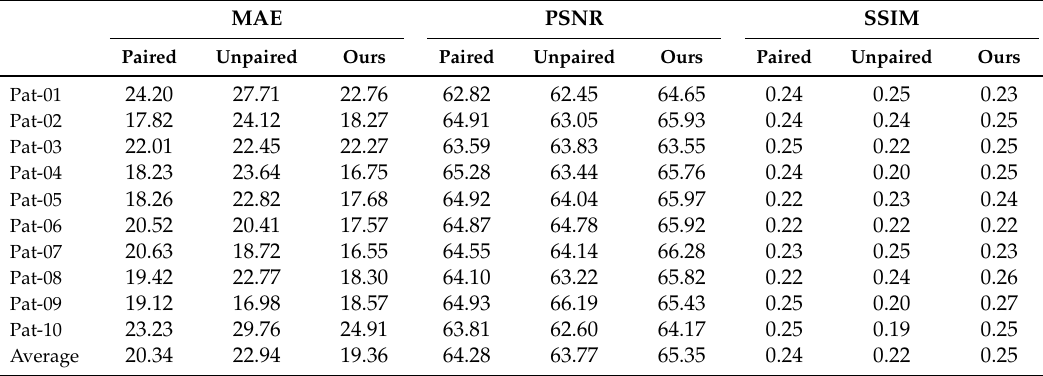
Table 1. MAE, PSNR, and SSIM evaluations between synthesized and reference MR images when training with paired, unpaired, and MR-GAN using paired and unpaired data together (Ours).